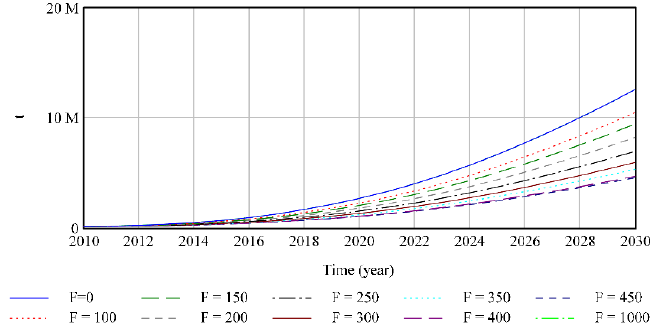
Figure 5. Impact of fines on total illegal dumping.